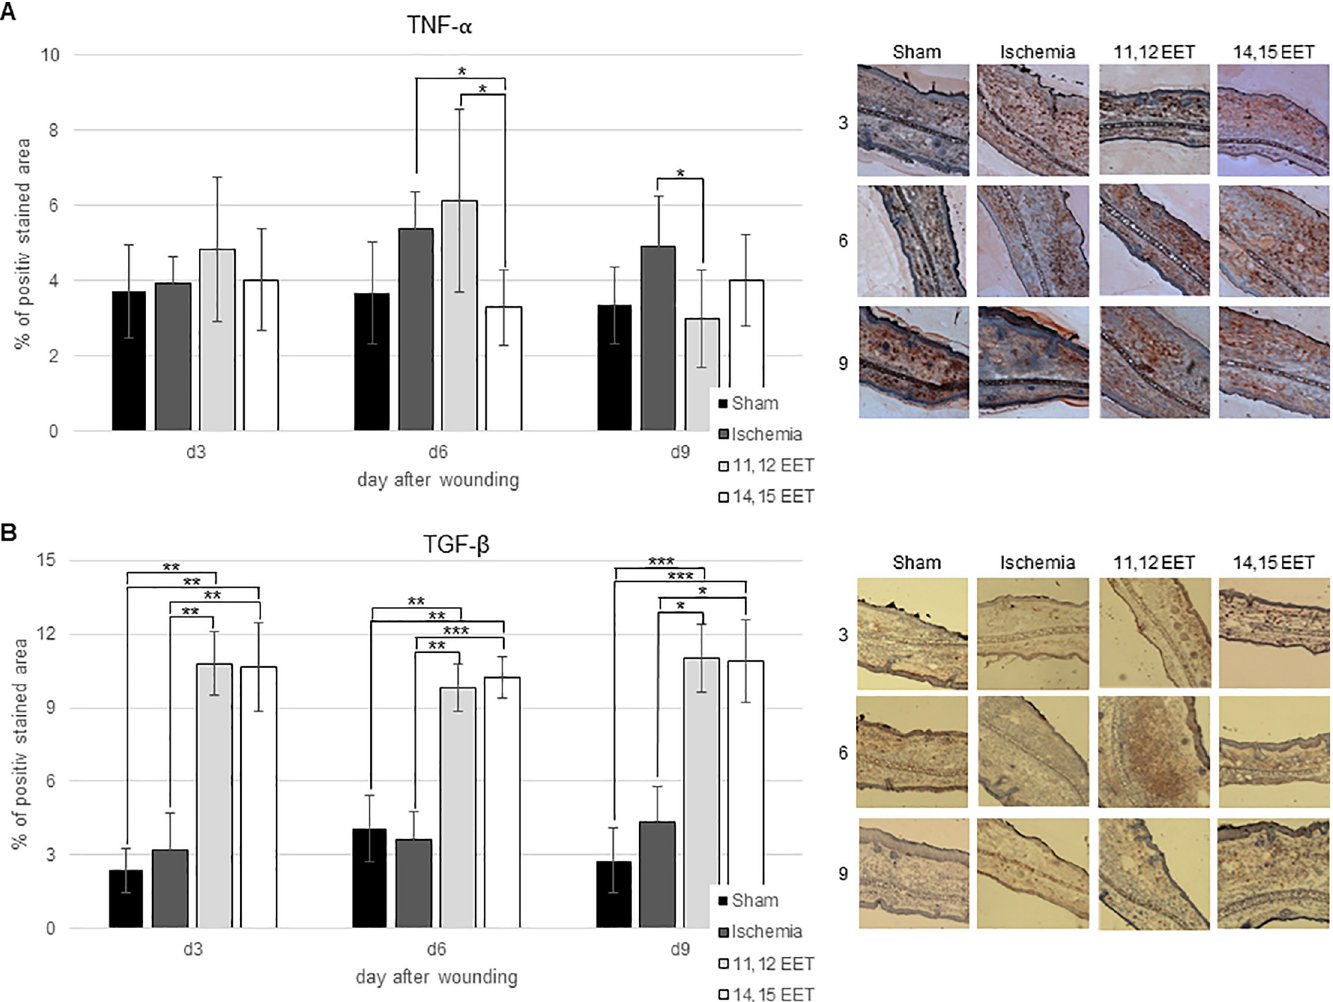
Fig 4. A Percentage of TNF- α positive area on day 3, 6, and 9 after wounding of control, ischemic and 11,12 as well as 14,15 EET treated ischemic wounds. On the right representative pictures of immunohistological staining. B Percentage of TGF- β positive area on day 3, 6 and 9 after wounding of control, ischemic and 11,12 as well as 14,15 EET treated ischemic wounds. On the right representative pictures of immunohistological staining (data is shown as mean ± SD; n = 8 ). � p < 0.05, ��� p < 0.001.